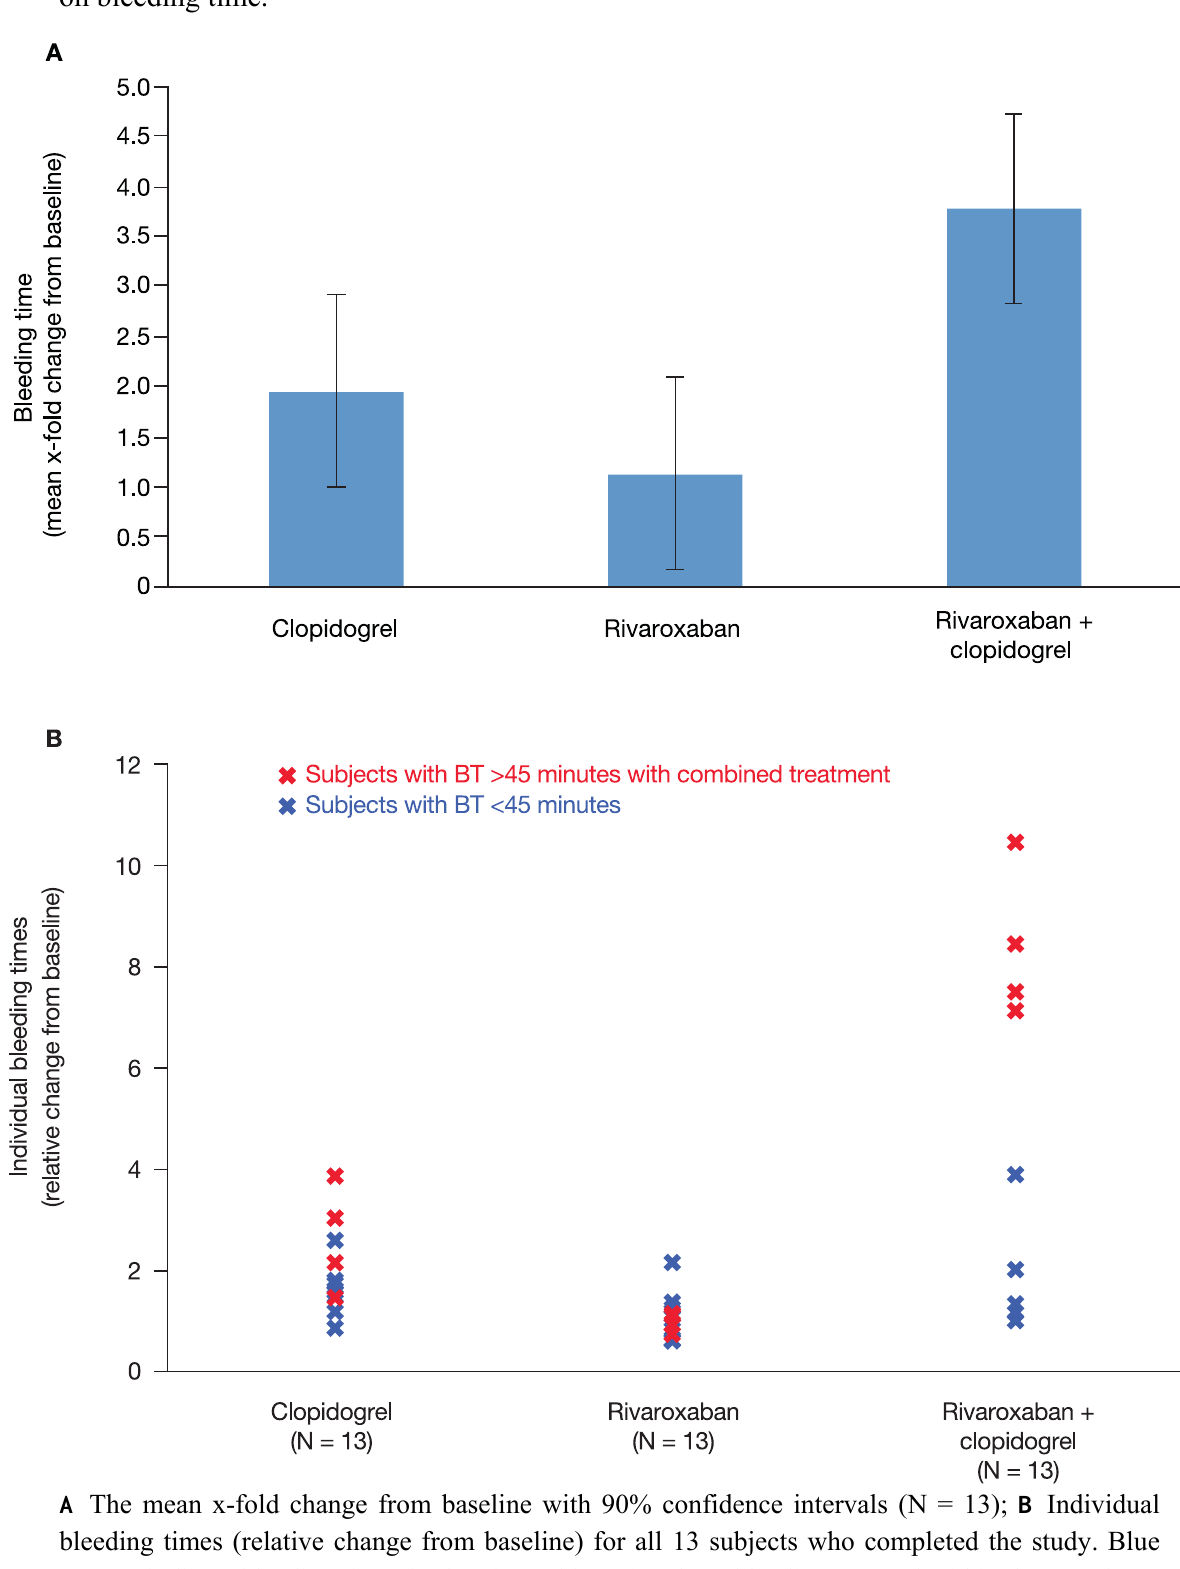
Figure 2. Bleeding time. The effect of clopidogrel and rivaroxaban alone and in combination on bleeding